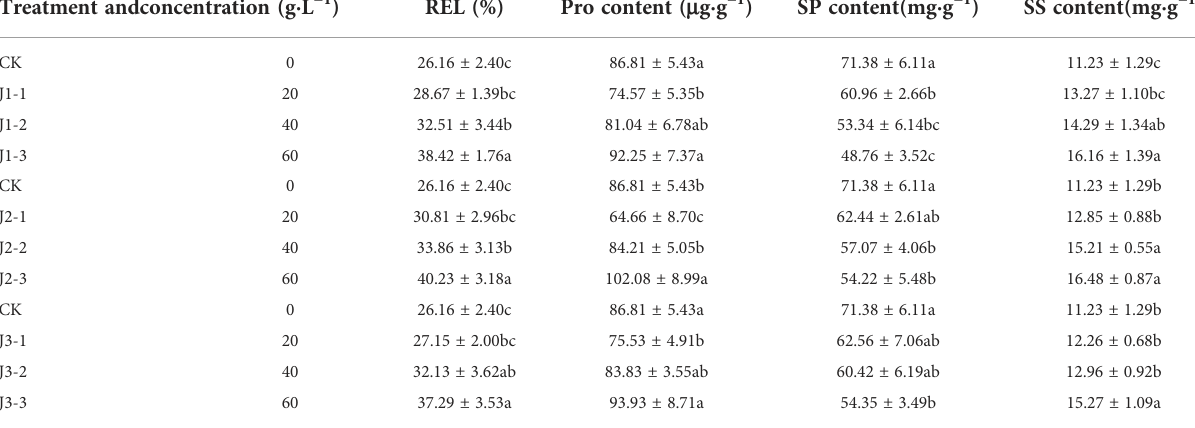
TABLE 1 Responses of osmoregulatory substance content in the leaves of sugarcane seedlings to different root aqueous extracts. Treatment andconcentration (g·L − 1